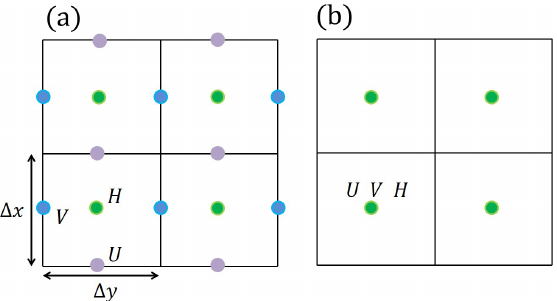
Figure 1. Sketches of the horizontal grid structure, alternating direction implicit (ADI) model: staggered grid ( a ), total variation diminishing (TVD) model: non-staggered grid ( b